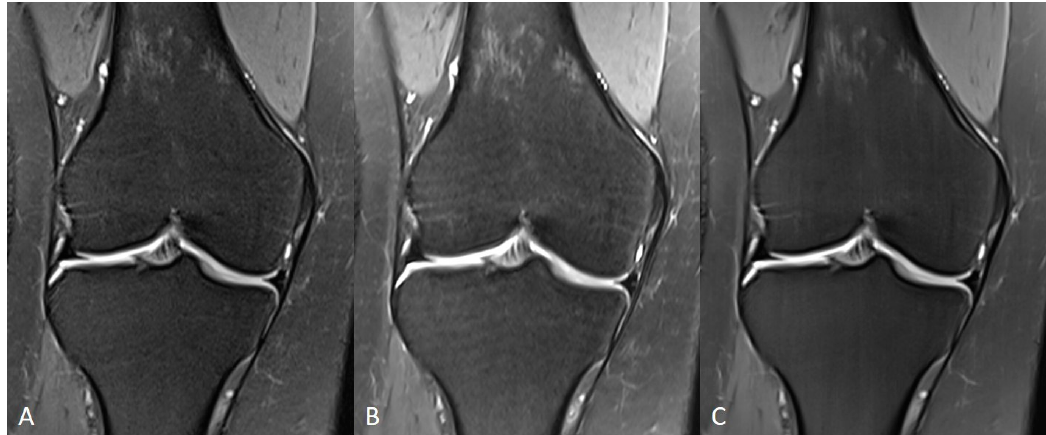
Figure 10. Comparison of TSE S ( A ), TSE DL raw data reconstructed with a standard (GRAPPA) method ( B ) and TSE DL ( C ) of a knee in coronal orientation. Note that the image quality in TSE DL ( C ) is increased compared to TSE S ( A ) and TSE DL with standard reconstruction ( B ). Table 3. Image Quality, Inter-reader Agreement and Comparison of TSE and TSE DL